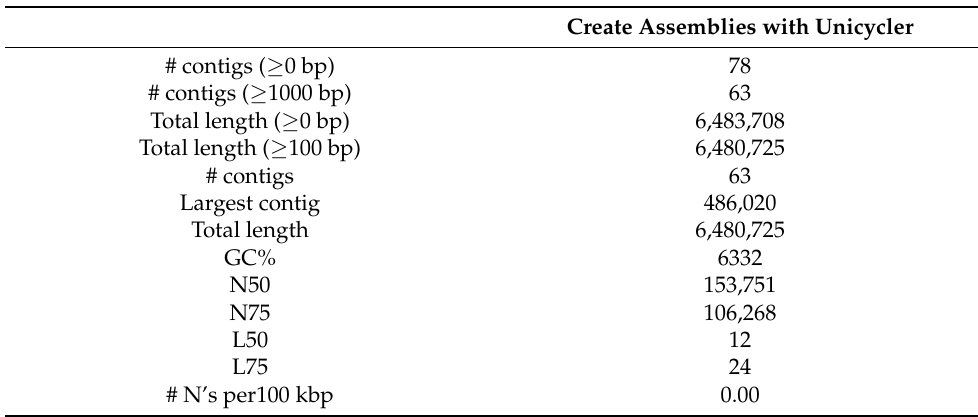
Table 3. Genome assembly